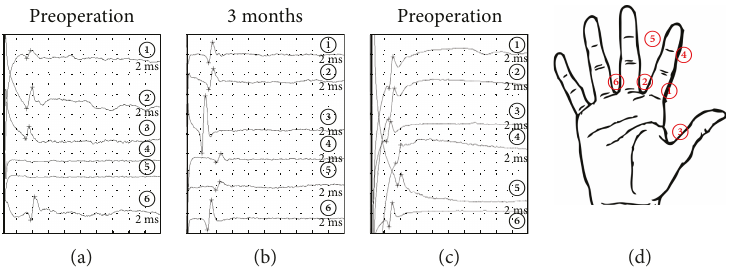
Figure 3: Results of the sensory nerve conduction study. Sensory nerve action potentials (SNAPs) were collected using the antegrade recording method by applying a stimulation to the digital nerve and deriving SNAPs from the forearm just above the median nerve with a surface electrode. (a) Preoperative period. No SNAPs were observed following stimulation at both sides of the index fi nger beyond the scar. (b) 3 months after surgery. SNAP was observed in each area. (c) 6 months after surgery. Sensory nerve conduction velocity increased compared with that 3 months after surgery. (d) The stimulation